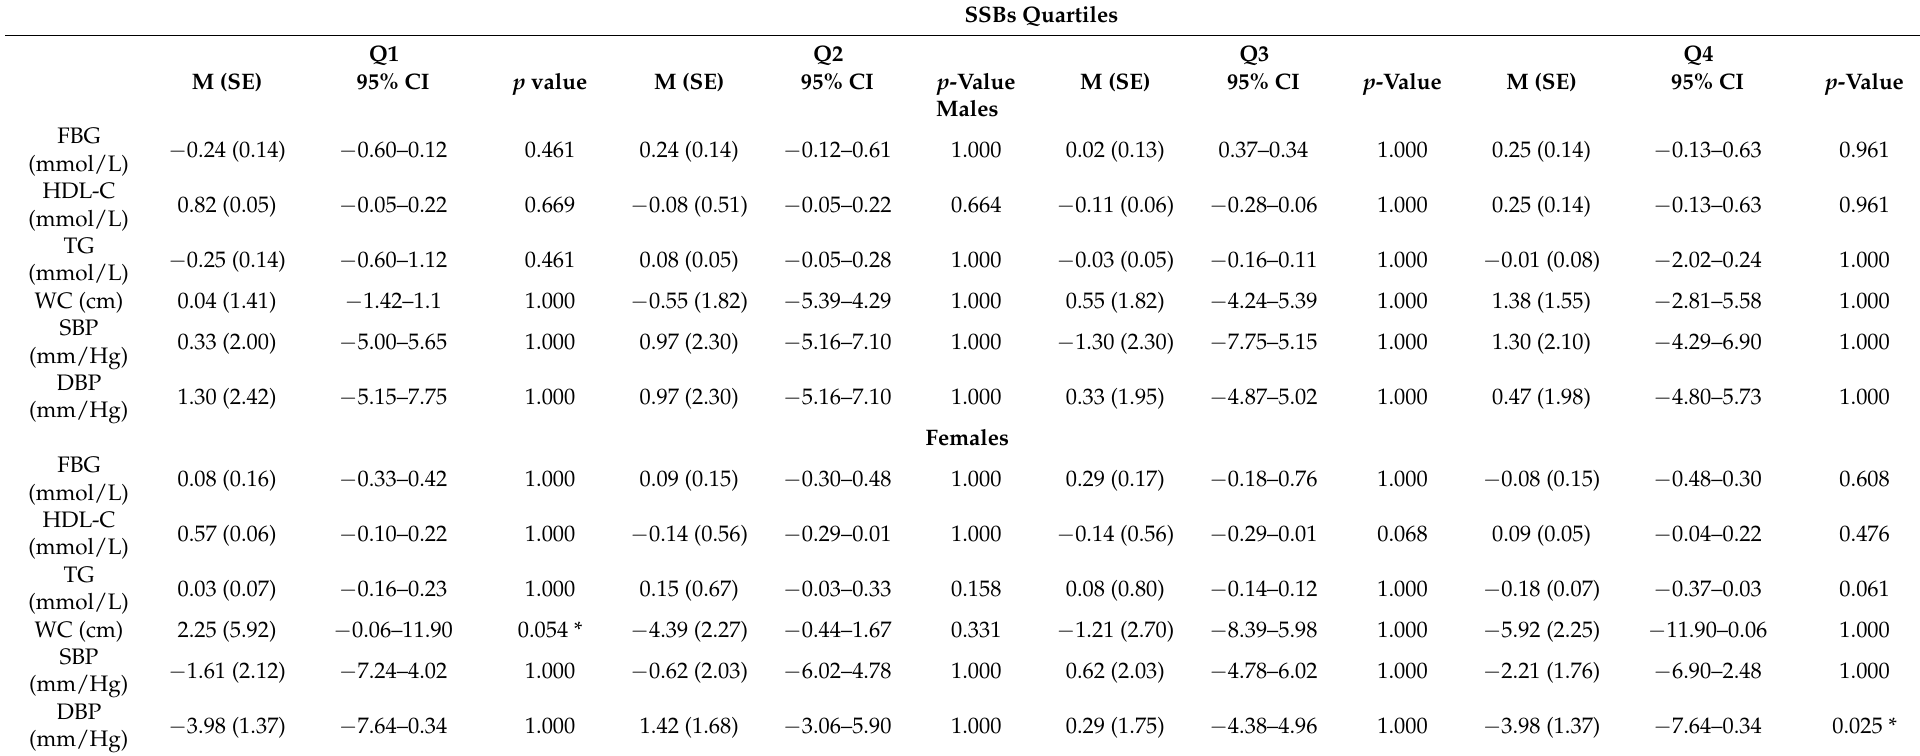
Table 2. The multiple comparisons for the observed mean of Ellisras young rural adults aged 22–30